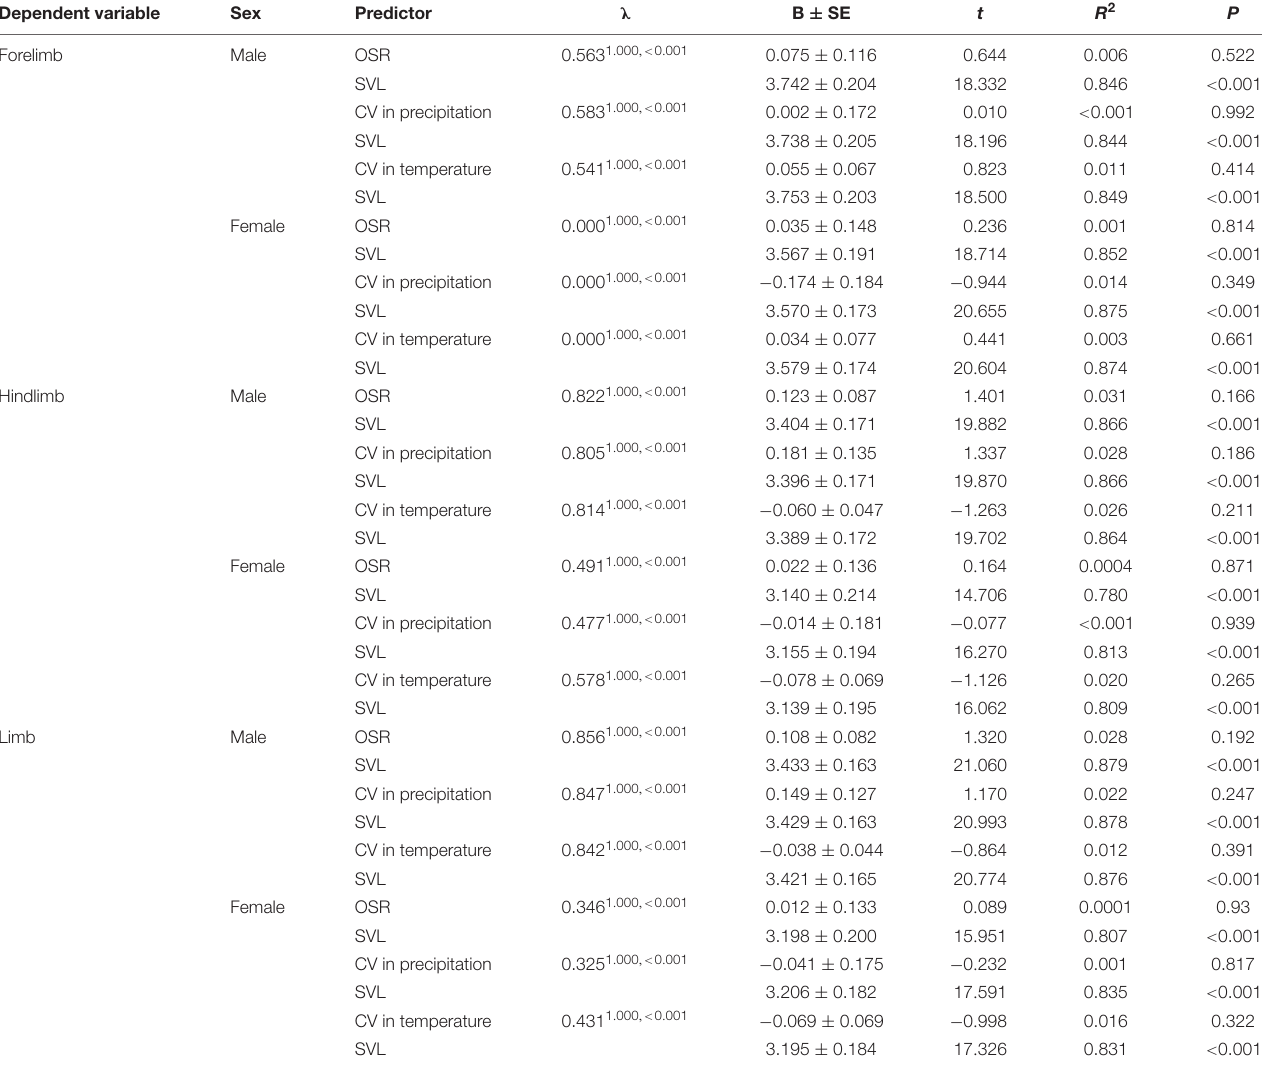
TABLE 3 | Effects of male-biased operational sex ratio (OSR) and environmental harshness[coefficient of variation (CV) in precipitation and coefficient of variation in temperature] on limb muscle mass among species of anurans. Dependent